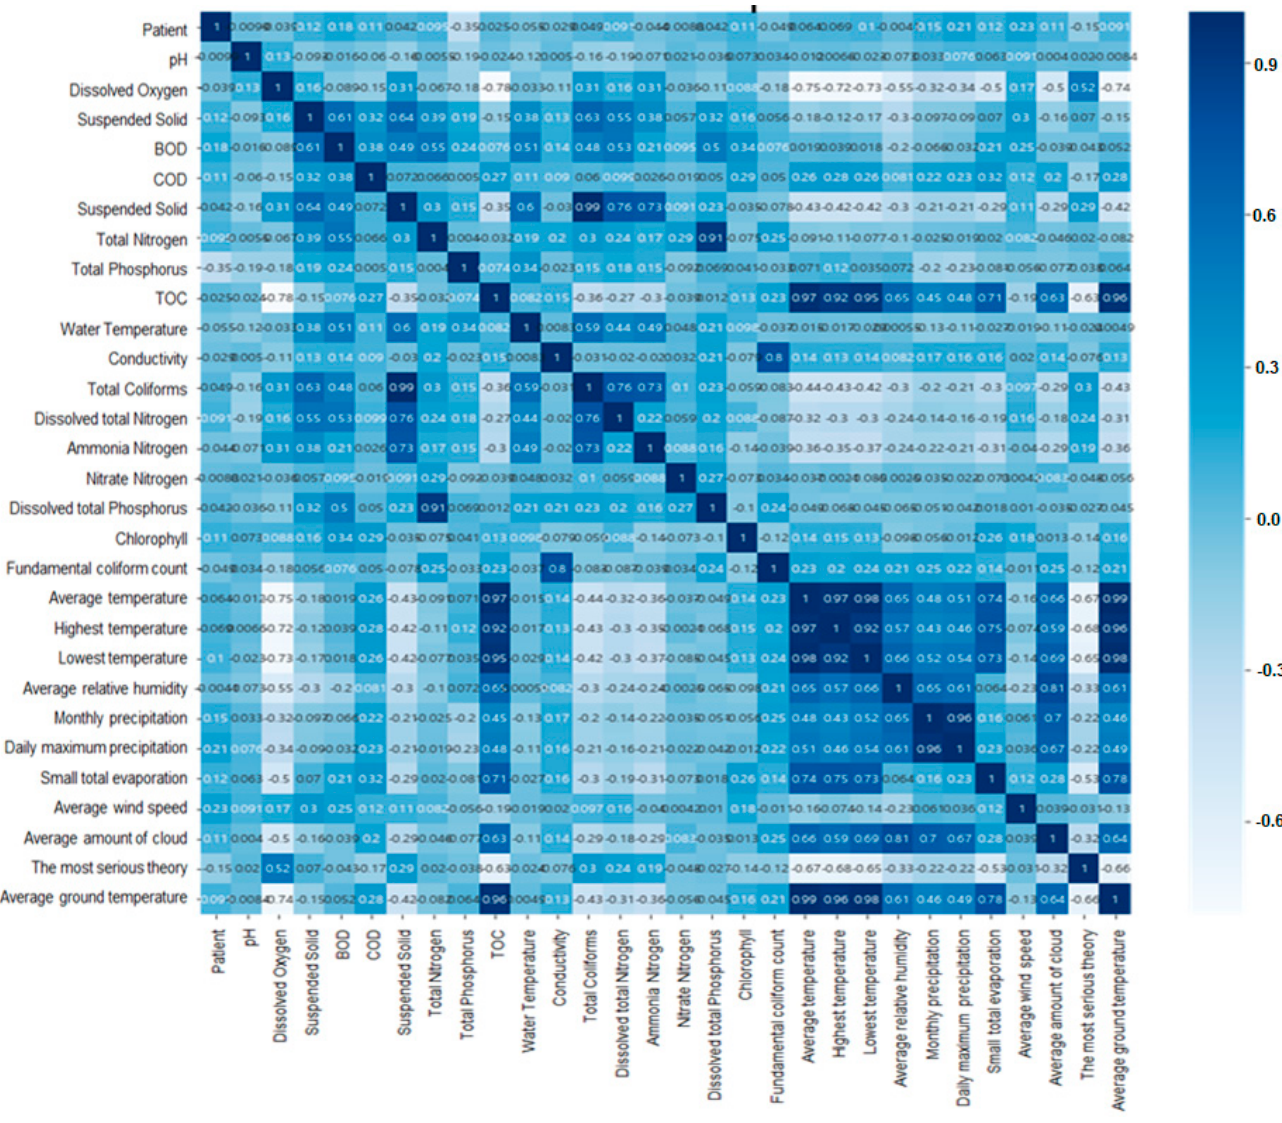
Figure 6. Validation of correlation coefficient between environmental factors using heatmap.